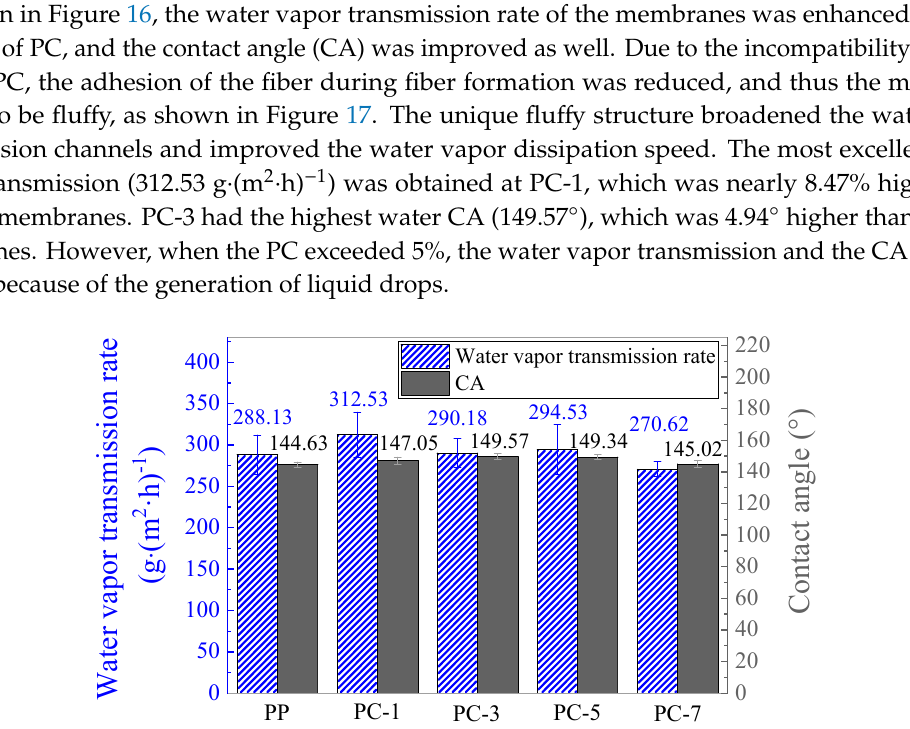
Figure 15. The quality factor of PP meltblown membranes containing different content of PC.